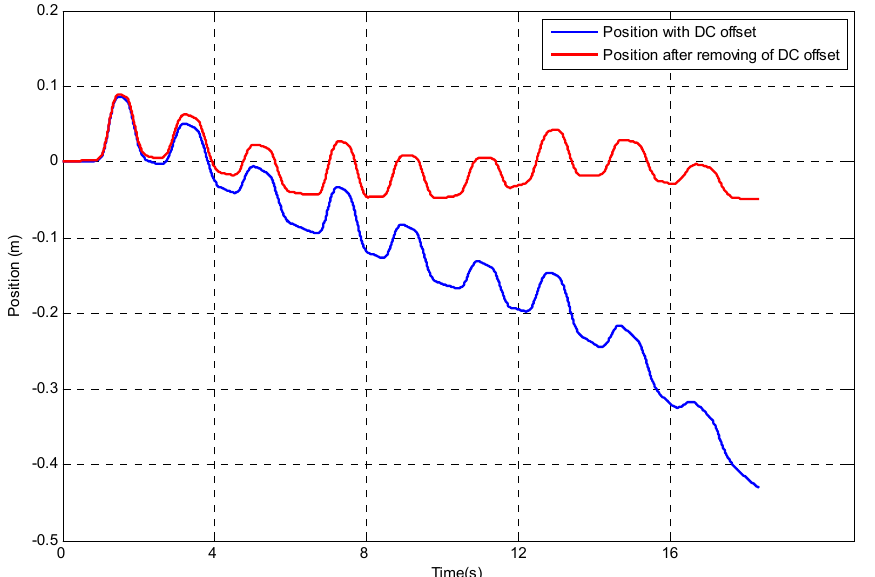
Figure 5. Position tracking before and after DC offset removal